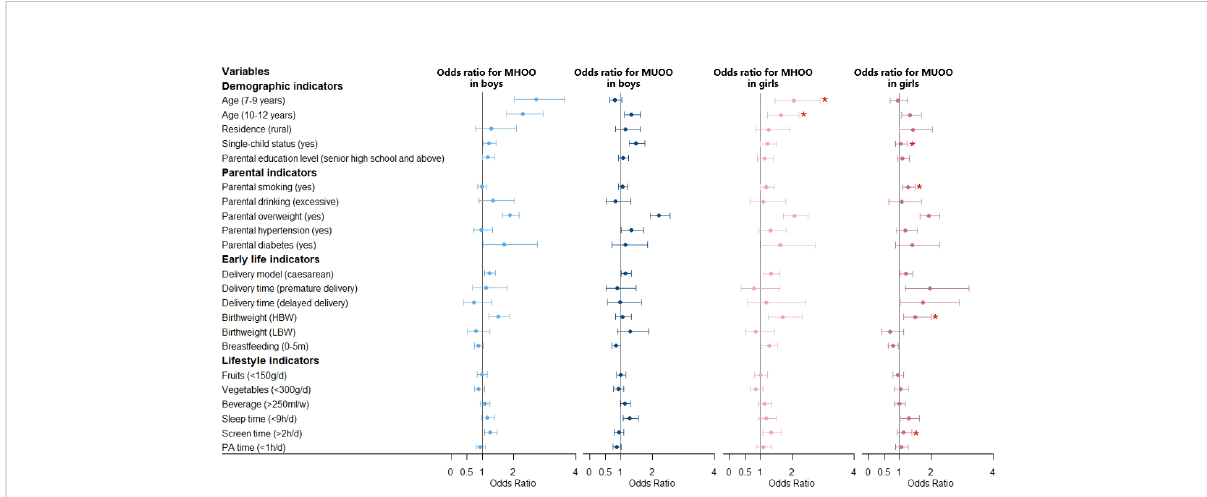
FIGURE 3 Association between MHOO/MUOO prevalence and risk factors strati fi ed by sex. Obesity phenotypes include metabolically healthy overweight and obesity (MHOO) and metabolically unhealthy overweight and obesity (MUOO), taking the participants without MHOO or MUOO as the reference group. Adjusted for age, residence, single-child status, parental education level, parental smoking, parental drinking, parental overweight, parental hypertension, parental diabetes, delivery model, delivery time, birth weight, breastfeeding, fruits, vegetables, beverage, sleep time, screen time, physical activity (PA) time. *Signi fi cant interaction with sex in the whole model. NBW, normal birth weight; LBW, low birth weight; HBW, high birth